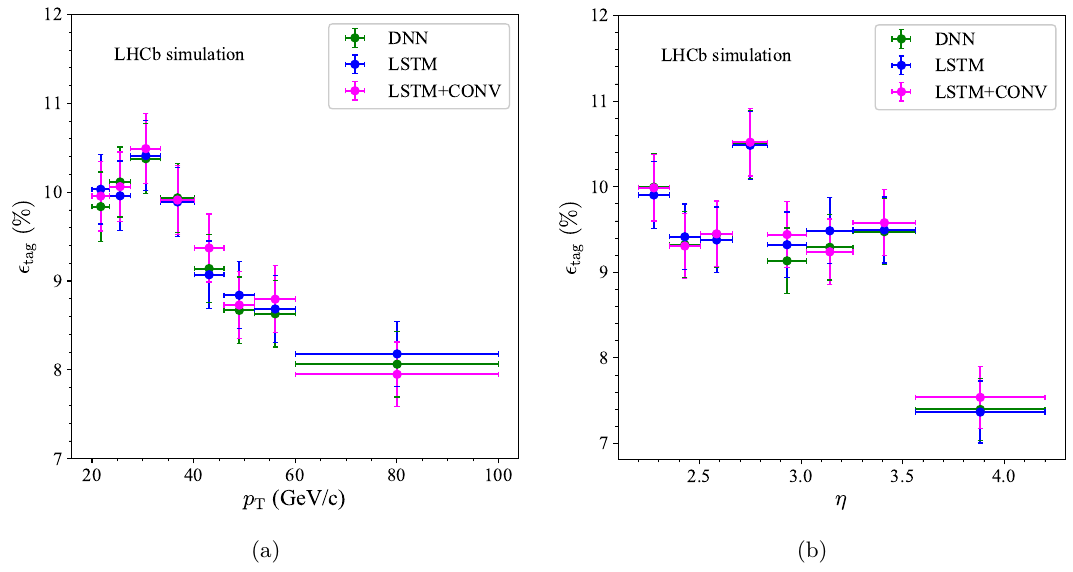
Figure 15. Tagging power (cid:15) tag with respect to (a) jet p T and (b) jet η for the complete dataset applied to different DNN models.